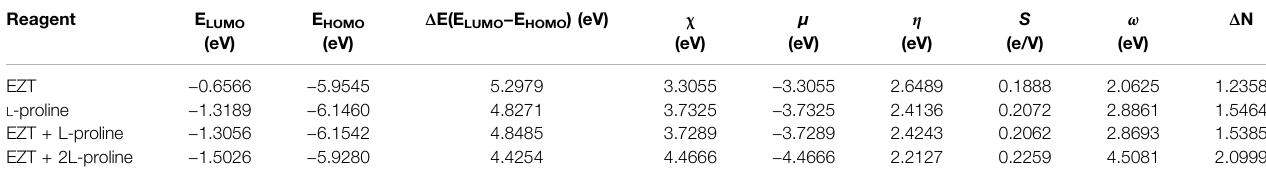
TABLE 4 | Calculated E LUMO , E HOMO , energy gap (E LUMO – E HOMO ), chemical potential ( μ ), electronegativity ( χ ), global hardness ( η ), global softness ( S ), and global electrophilicity index ( ω ) for EZT, L -proline, and EZT- L -proline (EZT + L-proline and EZT + 2L-proline).